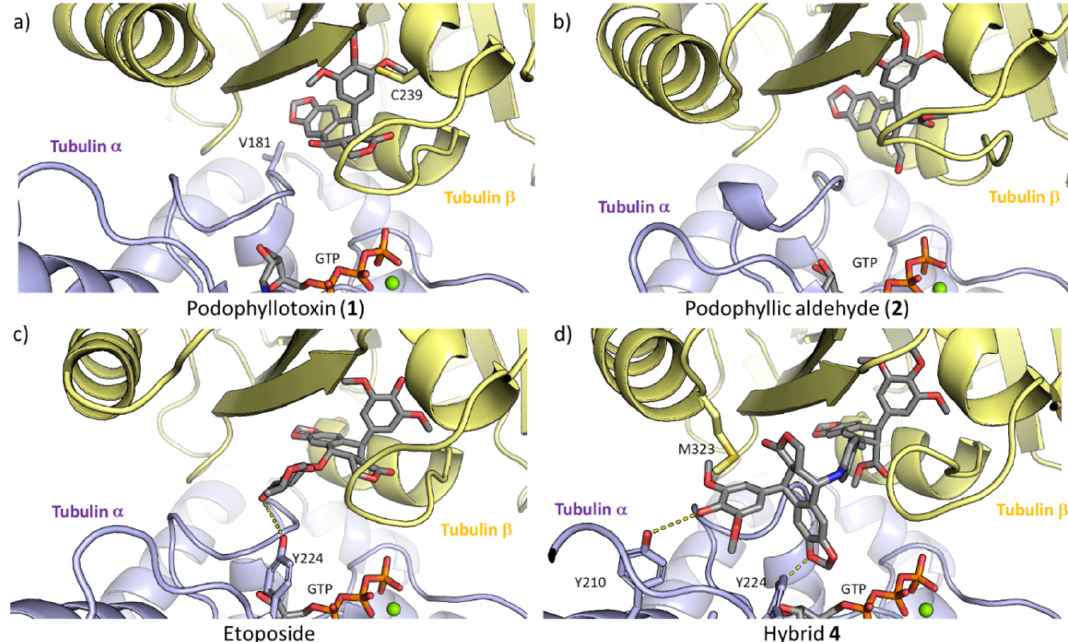
Figure 6. Docking complexes of compounds in the colchicine site of tubulin. ( a ) podophyllotoxin ( 1 ), ( b ) podophyllic aldehyde ( 2 ), ( c ) etoposide and ( d ) hybrid 4 . GTP, the inhibitors, and those residues that interact with the inhibitors via hydrogen bonds are shown atomistically. The two protomers tubulin α and β are shown in yellow and purple, respectively.